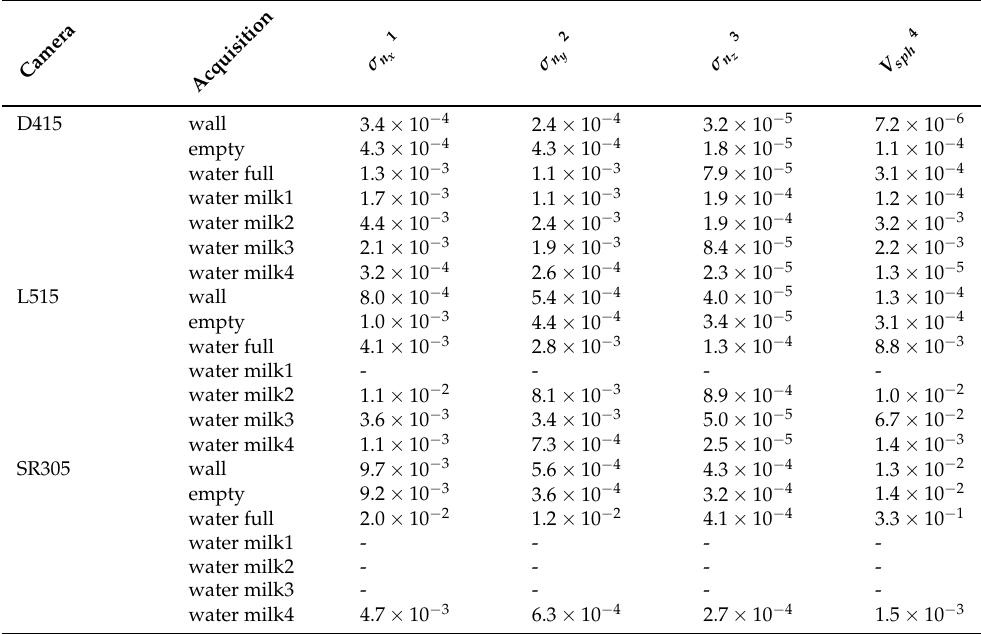
Table 6. Camera precision in terms of plane modelling consistency: Standard deviations of the normal components and spherical variance of the